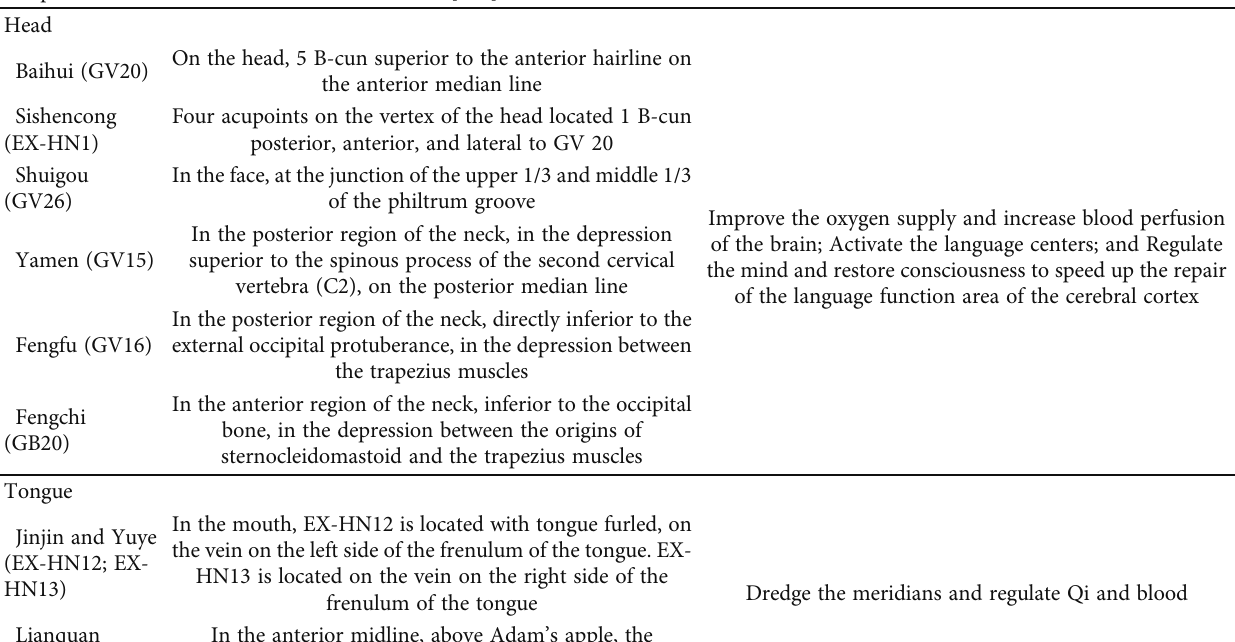
Table 1: Acupoints possibly used in